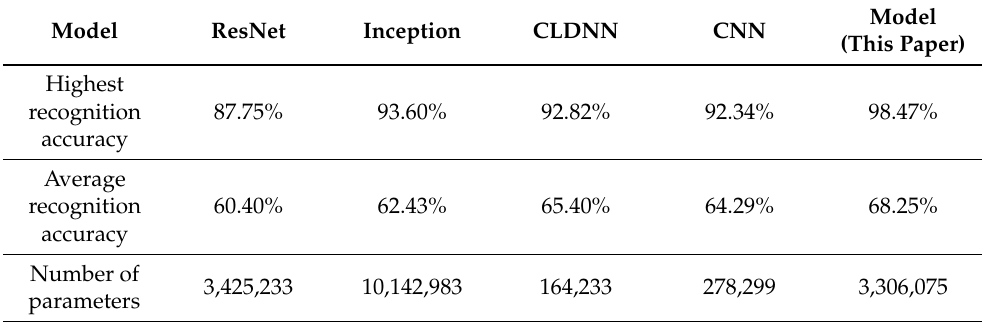
Table 12. Recognition accuracy and number of parameters of five models.